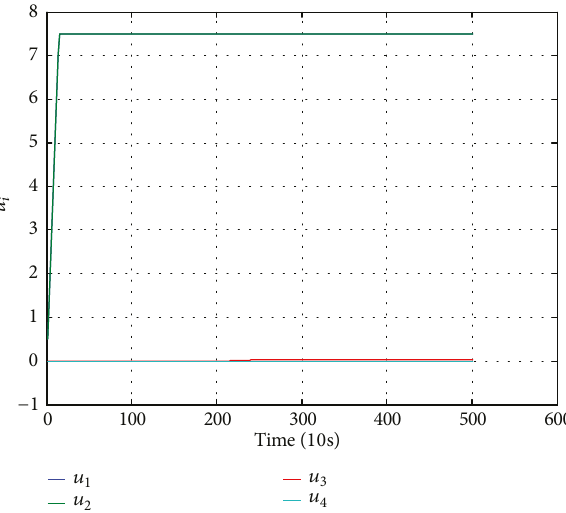
Figure 8: The variation curve of system input when the load of generator unit is 400MW, 𝑢 𝑗 ∈ [0,6],Δ𝑢 𝑗 = 0.5 .